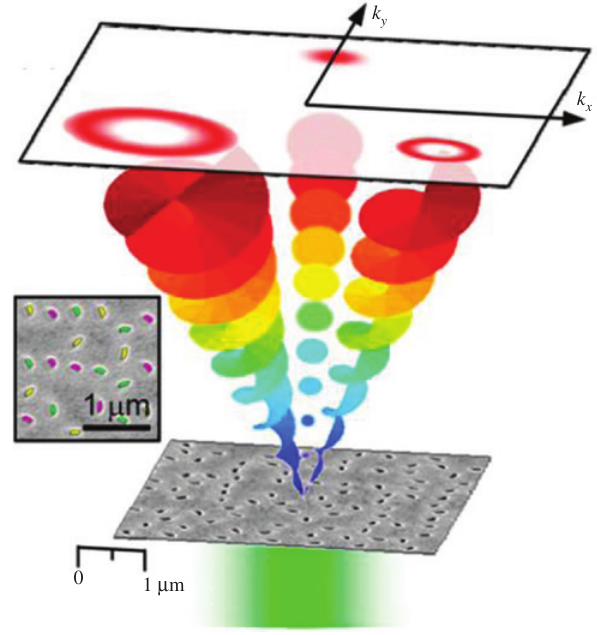
Figure 20: Schematic of spin-controlled far-field phase functions with different orbital angular momenta generated by a disorder gradient metasurface. The inset shows the mixed antenna groups, where each color corresponds to a different wavefront. Adapted from Ref. [137].